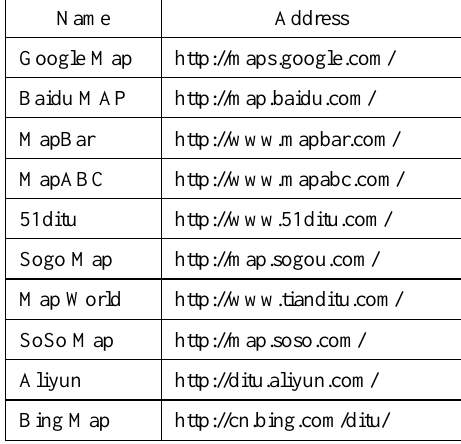
Table 1. The selected